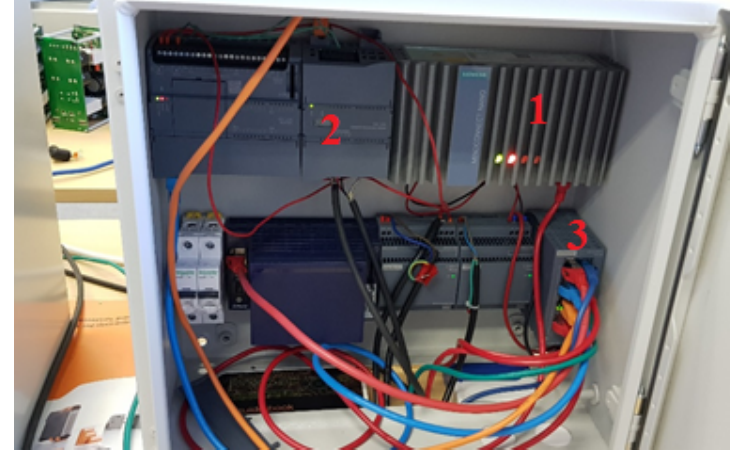
Figure 2. Data acquisition devices.